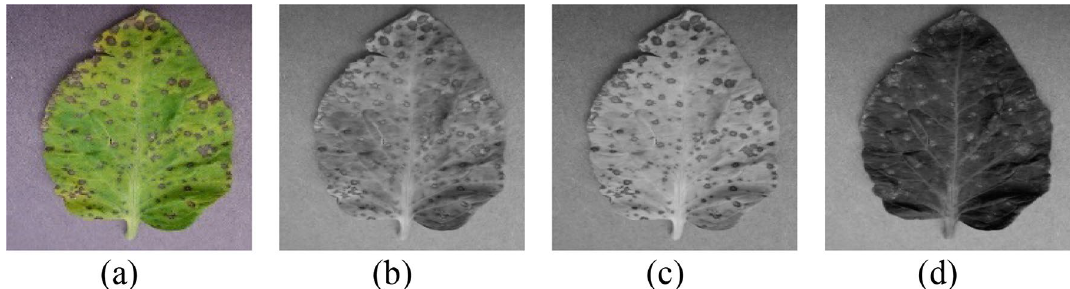
Fig. 4 The block diagram of the single channel capsule network in the proposed architecture. L1 Layer (Convolutional Layer): 9 × 9 convolutional with 256 output channel. L2 Layer: Convolutional with 256 output channels. These channels are divided into 32